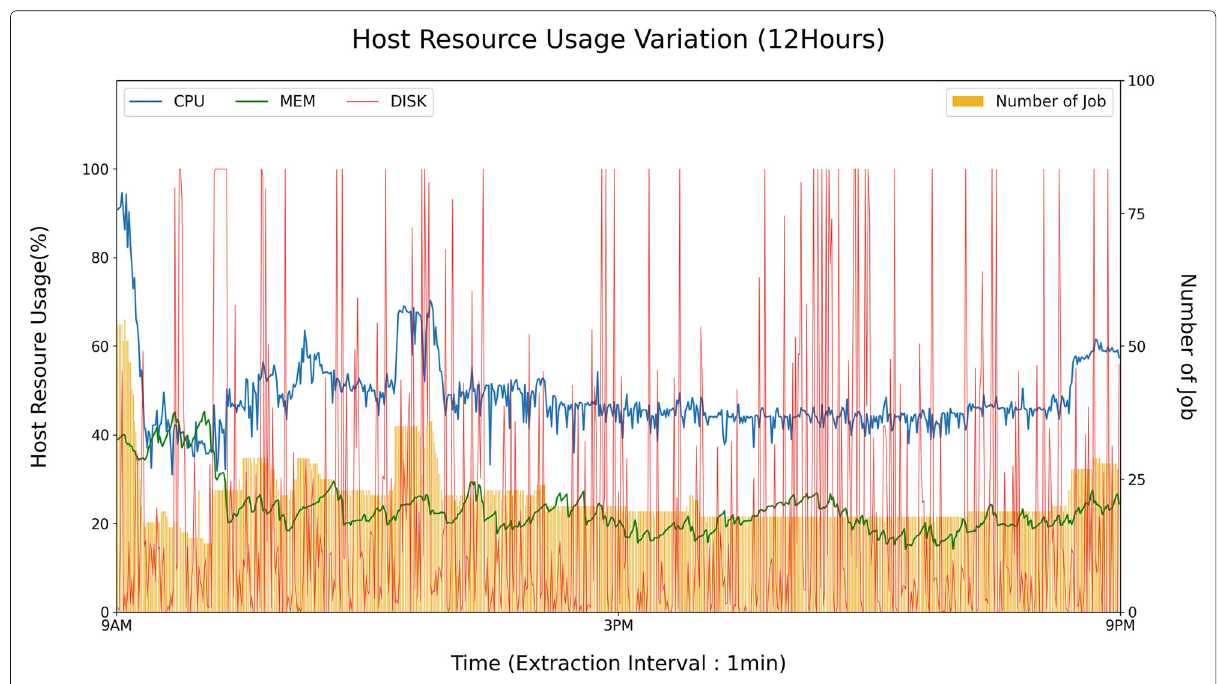
Fig. 2 Host Usage Variation over 12